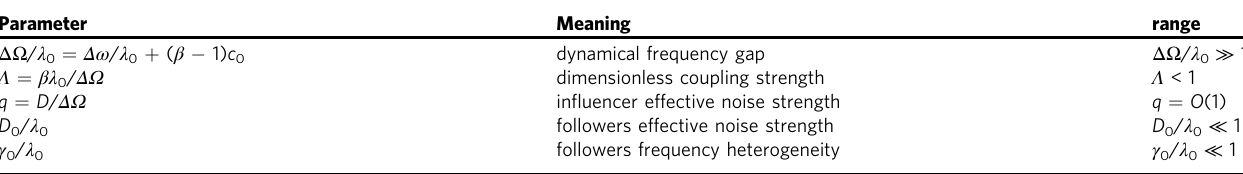
order parameter R as a function of q . After a transient, the order parameter is independent of the initial conditions. At an optimal noise strength, R reaches its maximum (in expected value), as shown in Fig. 1 for ΔΩ / λ 0 = 18 (panel c) and for ΔΩ / λ 0 = 198 (panel d). The solid line is a theoretical prediction in the ther- modynamic limit for heterogeneous followers using a slow-fast approximation. Frequency heterogeneity and noise in the fol- lowers have qualitatively and quantitatively the same desyn-